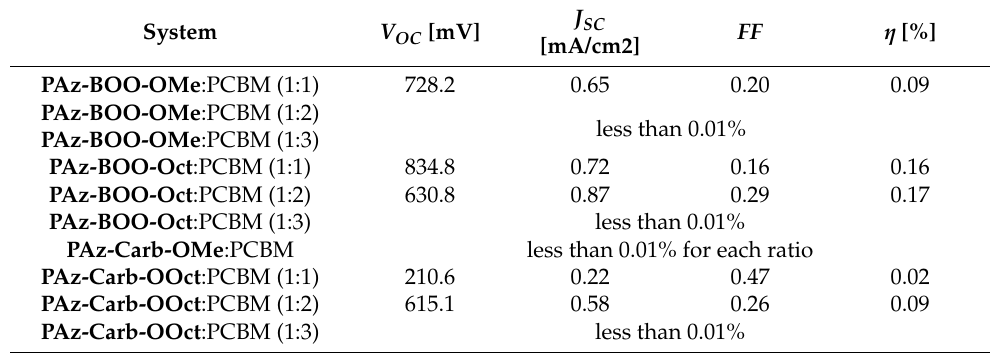
Figure 8. Current density–voltage ( J-V ) characteristics of bulk-heterojunction (BHJ) systems, consist- ing investigated oligo- and polyazomethines. Donor:acceptor ratios 1:2 for all, except for PAz-BOO- OMe , where the ratio D:A is 1:1. Table 6. Photovoltaic parameters of the BHJ photovoltaic systems, consisting investigated